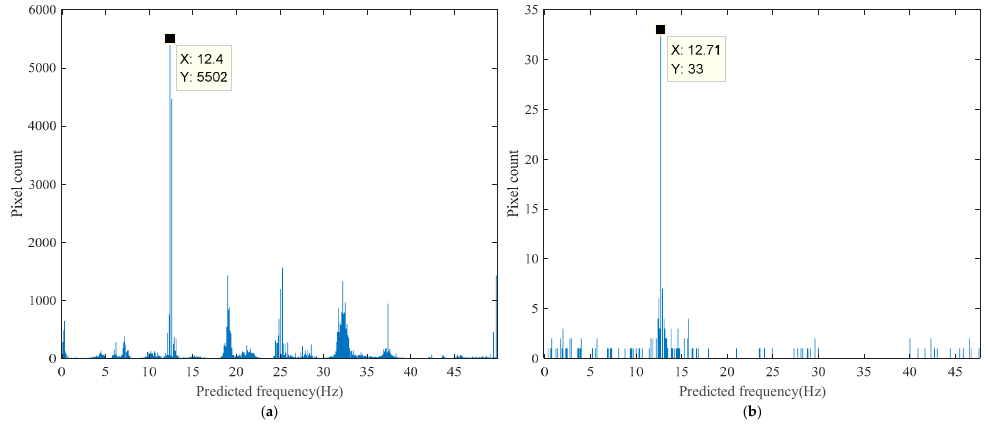
Figure 10. Laboratory experimental results of the proposed method: ( a ) Histogram of the predicted frequency distribution; ( b ) Histogram of the predicted frequency distribution after edge enhancement.